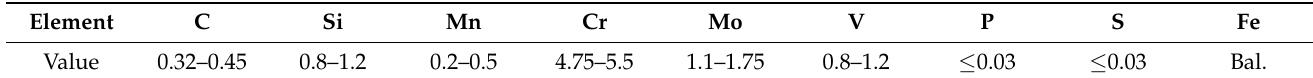
Table 2. Main components of substrate (%).